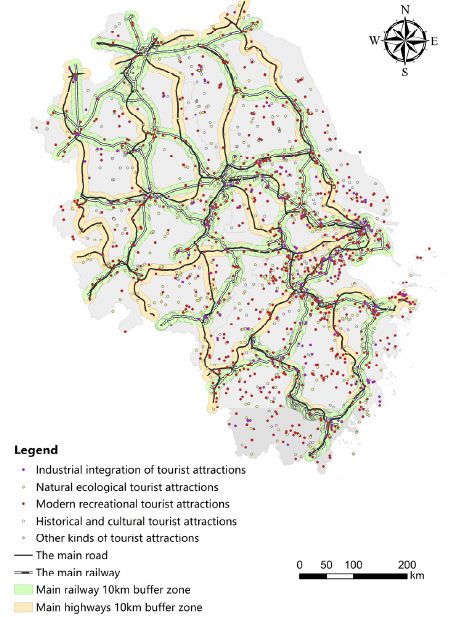
Figure 7. Coupling of the main traffic lines and the spatial distribution of tourist attractions.